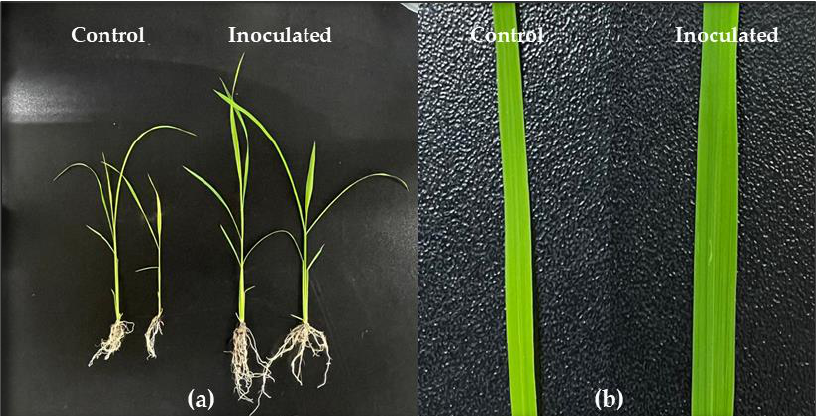
Figure 4. The effect of GN70 on the growth promotion of rice plants under greenhouse conditions. ( a ) Seeds were used as control; ( b ) seeds were pretreated with bacterial inoculation and then transferred into the soil pot. Measurement was taken after 4 weeks of germination.